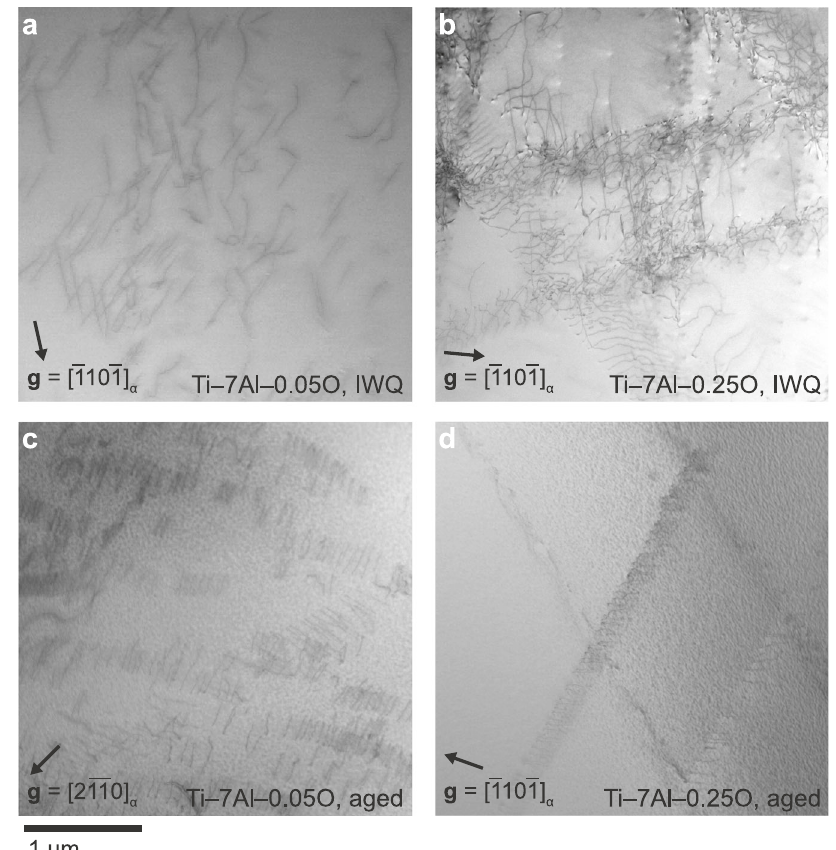
Fig. 2 | STEM images of dislocation con fi gurations after stress relaxation. The images show defect structures produced in Ti – 7Al – 0.05O and Ti – 7Al – 0.25O, in IWQ and aged conditions (550°C for 49d). STEM micrographs recorded for two- beam condition around B = f 0111 g as indicated. a In the low-oxygen, disordered material, dislocations are able to travel freely across a grain. Some dislocation pairing is evident, likely due to short-range order of aluminium that was not sup- pressed in quenching at such high Al content. b The addition of 2000 ppmw O